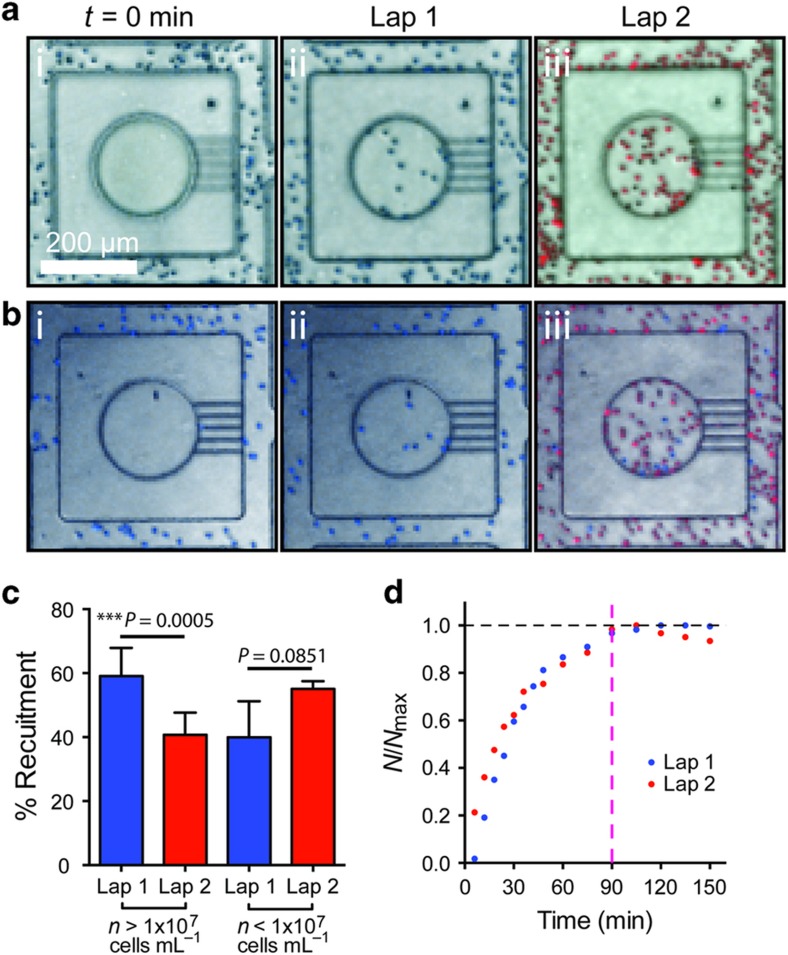
Neutrophils do not produce a ‘stop signal’. (a) Images of the neutrophil reservoir after first and second chemotaxis laps with initial neutrophil density >107 cells mL−1. (b) Images of the neutrophil reservoir after first and second chemotaxis laps with initial neutrophil density <107 cells mL−1. (c) Plot of neutrophil recruitment in first and second wave of chemotaxis for two different initial cell-loading densities (N=3. Error bars=mean±standard error of the mean). (d) Plot of the variation of normalized neutrophil recruitment with time for first and second laps of chemotaxis. Recruitment stabilized at approximately t=90 min (dashed magenta line).